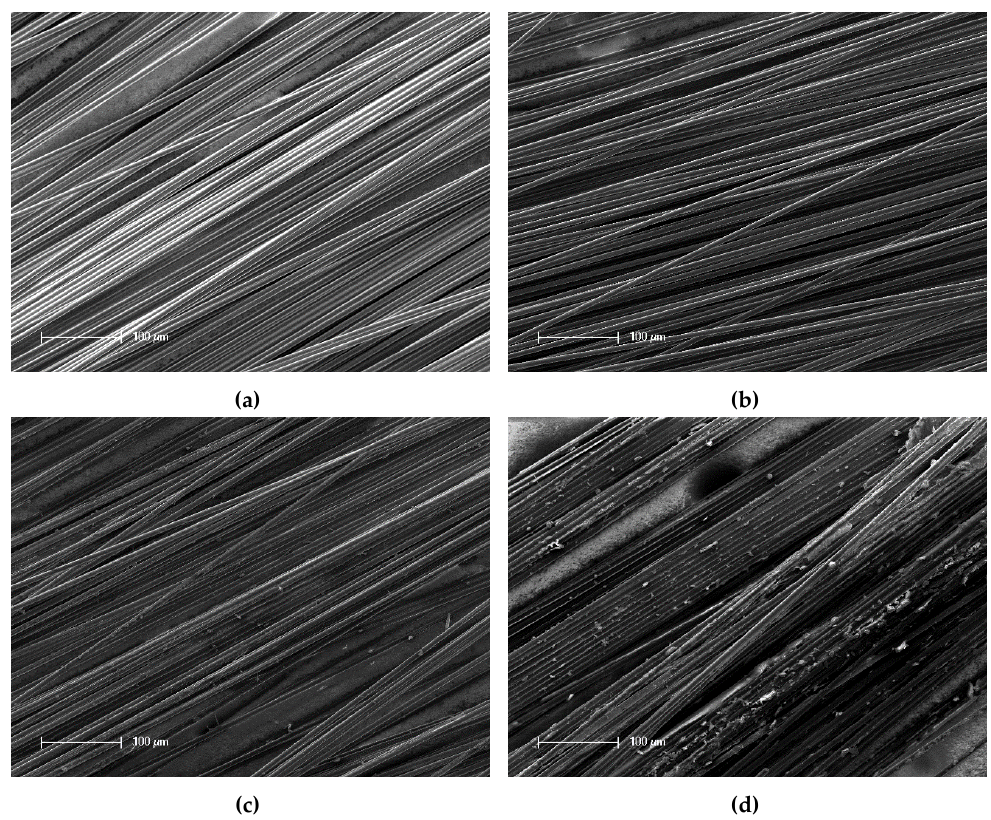
Figure 5. Scanning electron microscopy (SEM) images of the filaments: ( a ) reference, ( b ) reference without the sizing agent, ( c ) detached and treated with 66% power, and ( d ) detached and treated with 96% power.